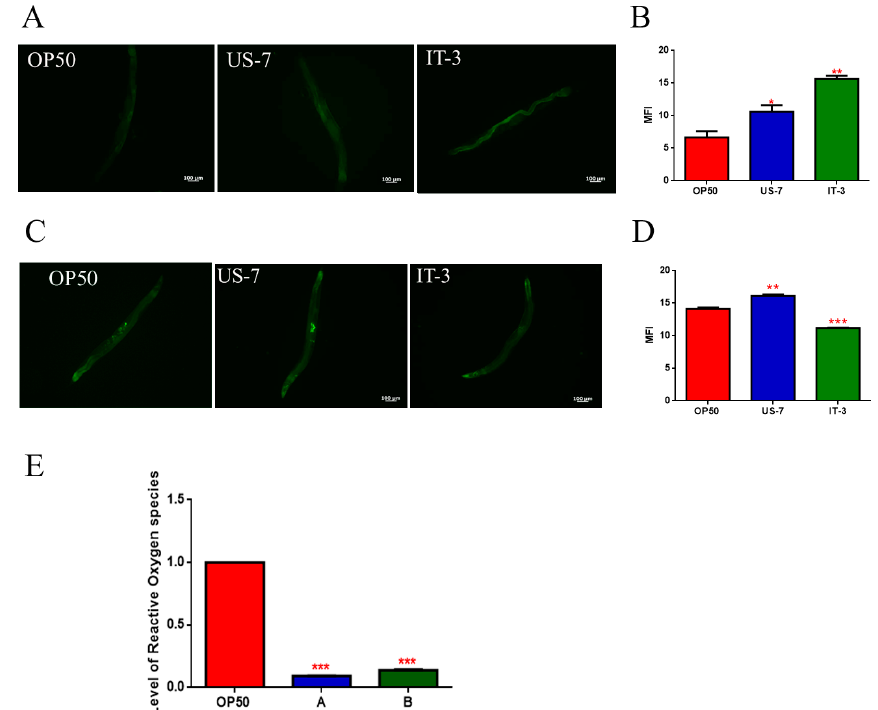
Figure 6. Lipofuscin and oxidative stress analysis in nematodes fed OP50, US-7, or IT-3. ( A ) Autofluorescence of lipofuscin granules in C. elegans wild type strain fed OP50, US-7, or IT-3 on day 13. Scale bar = 100 µm. ( B ) Mean intensity fluorescence of autofluorescence of lipofuscin granules. ( C ) Fluorescence microscopy of OP50, US-7, and IT-3-fed-SOD-3::GFP nematode strain at the stage of 2-day adult. Scale bar = 100 µm. ( D ) Mean intensity fluorescence of C. elegans SOD-3::GFP transgenic strain fed OP50, US-7, or IT-3. ( E ) Measurement of ROS levels in N2 worms fed US-7 and IT-3 at 2 days of adulthood, compared to OP50 fed nematodes. Statistical analysis was evaluated by one-way ANOVA with the Bonferroni post-test; asterisks indicate significant differences (* p < 0.05, ** p < 0.01; *** p < 0.001). Bars represent the mean of three independent experiments.